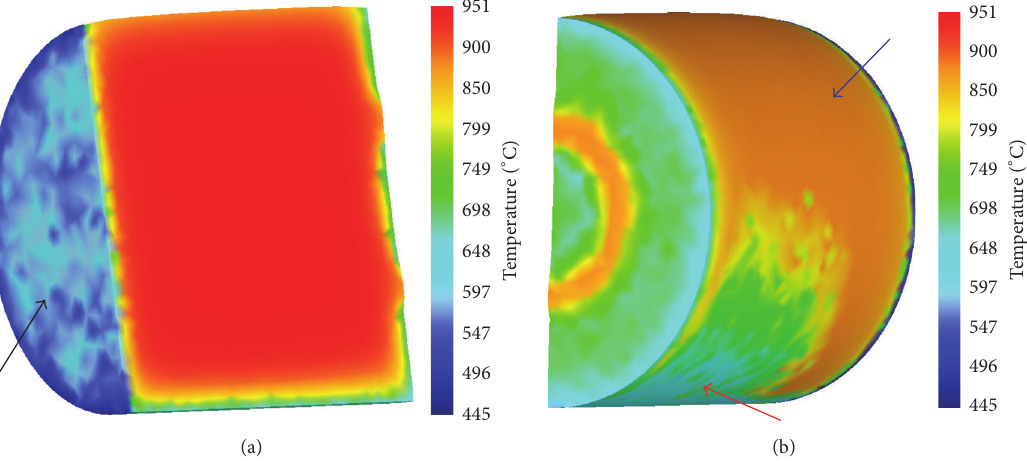
Figure 7: Distribution of temperature field of billet after